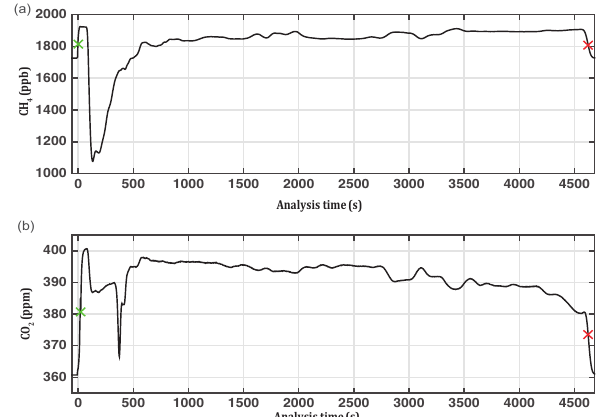
Figure 5. Picarro analysis of the AirCore-HR sample from the EdS- Stratéole flight on 29 August 2014. (a) CH 4 mixing ratios as a func- tion of the analysis time in seconds; (b) CO 2 mixing ratios as a function of the analysis time in seconds. The selected starting point of the sample is marked with a green cross and marks the 0 of the analysis time; the selected ending point of the AirCore-HR sample is marked with a red